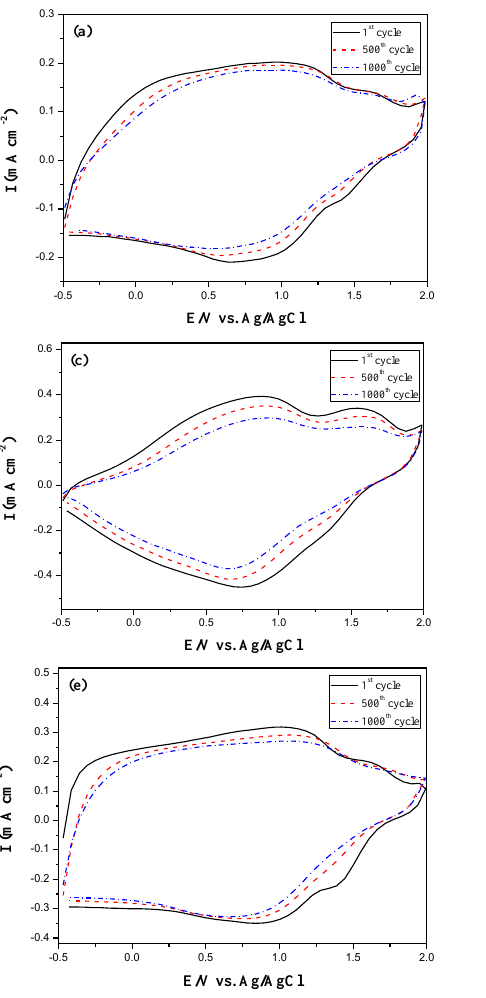
Figure 10. Cyclic voltammograms of ( a ) PDTC/PEDOT-PSS, ( b ) P(DTC- co -BTP)/PEDOT-PSS, ( c ) P(DTC- co -BTP2)/PEDOT- PSS, ( d ) P(DTC- co -TF)/PEDOT-PSS, and ( e ) P(DTC- co -TF2)/PEDOT-PSS devices with a scan rate of 500 mV s − 1 between the 1st and 1000th cycles.